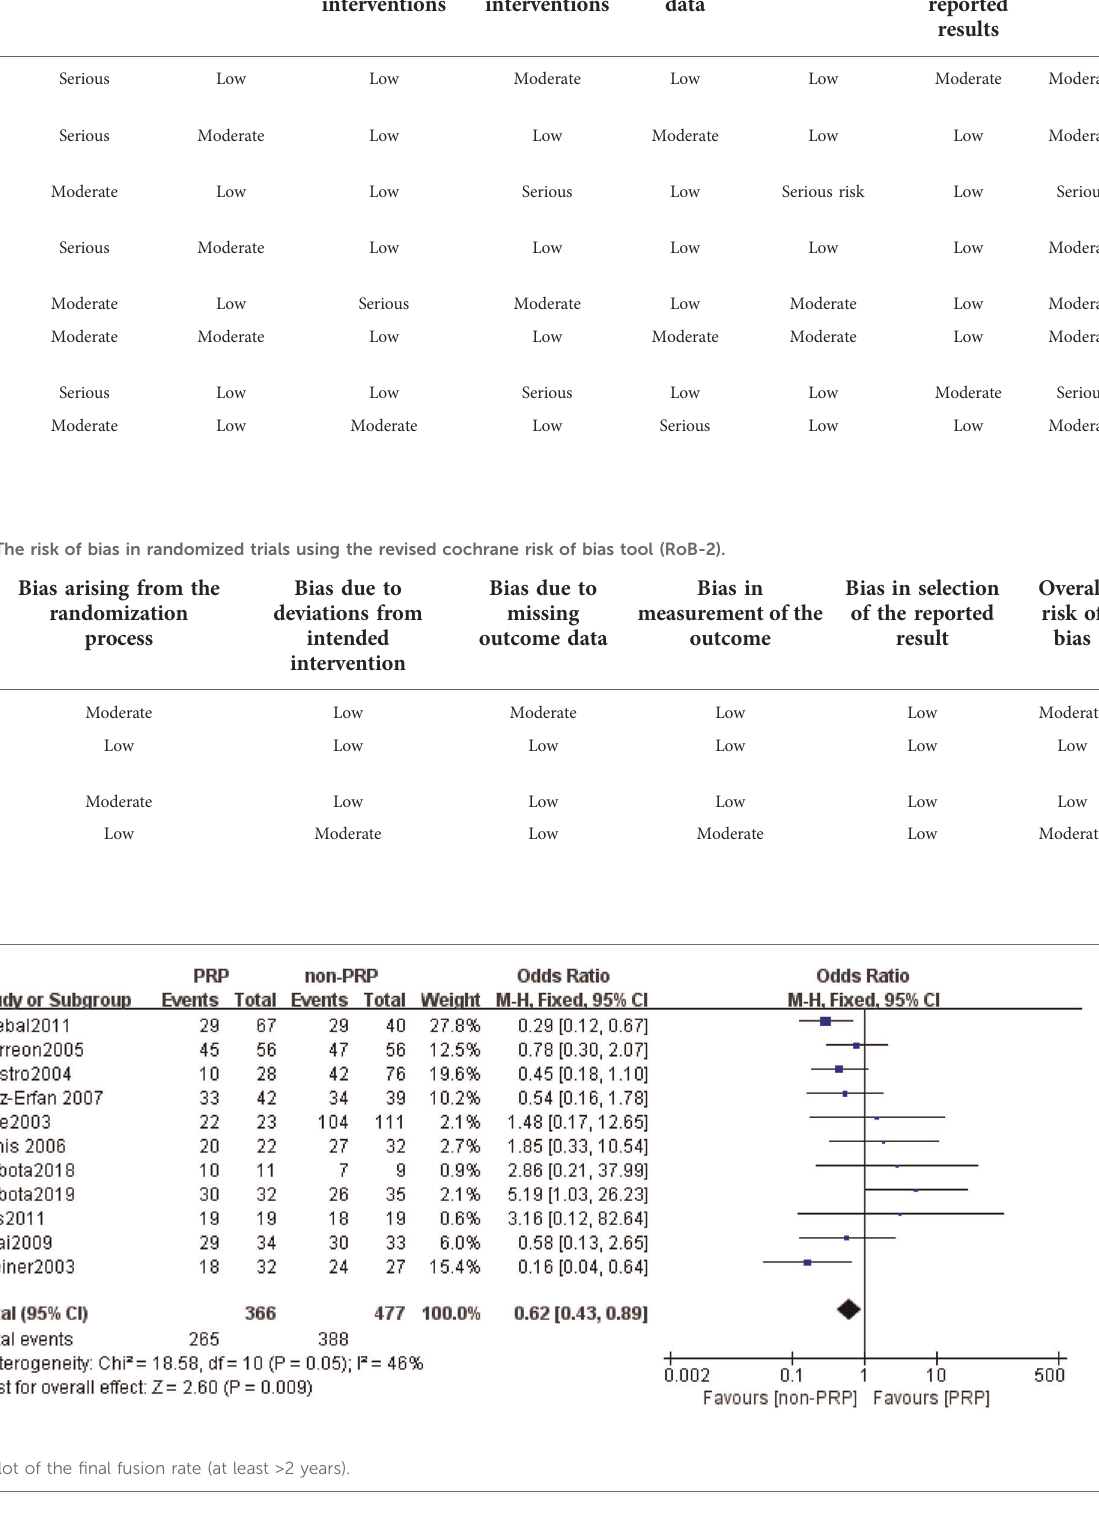
TABLE 4 The risk of bias in non-randomized trials using risk of bias in Non-randomized studies of interventions (ROBINS-I). Study ID